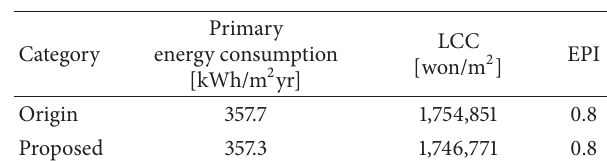
Table 7: Selected alternative when considering the primary energy consumption preferentially.